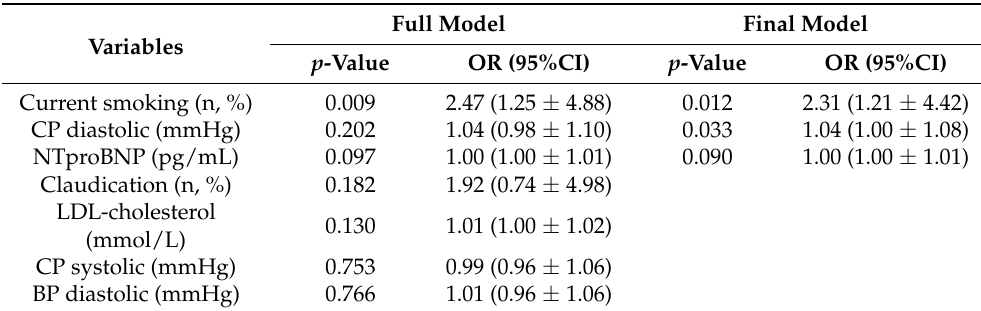
Table 3. Results of stepwise backward logistic regression analysis of atherosclerotic plaques in carotid arteries.